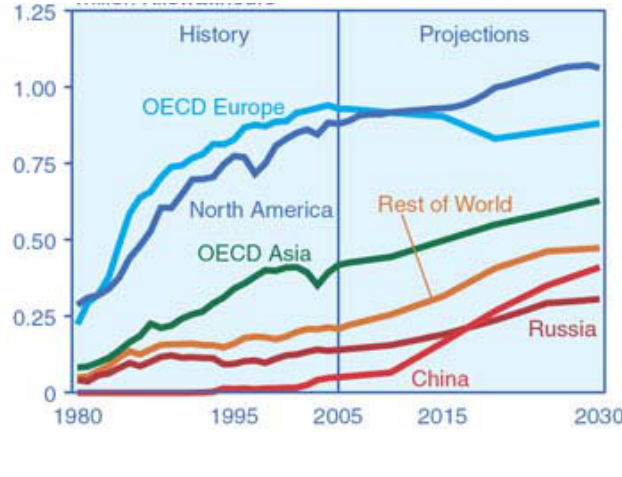
Figure 15. World nuclear electricity generation projections, in units of PWh (after